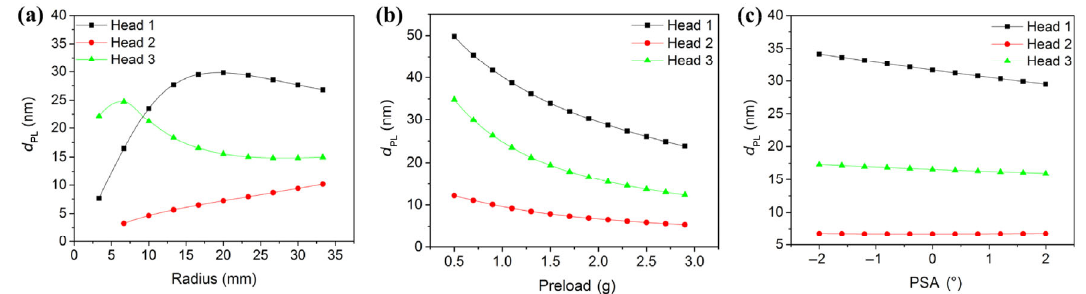
Fig. 5 Static performance of the PFHs: (a) angles (PSAs).